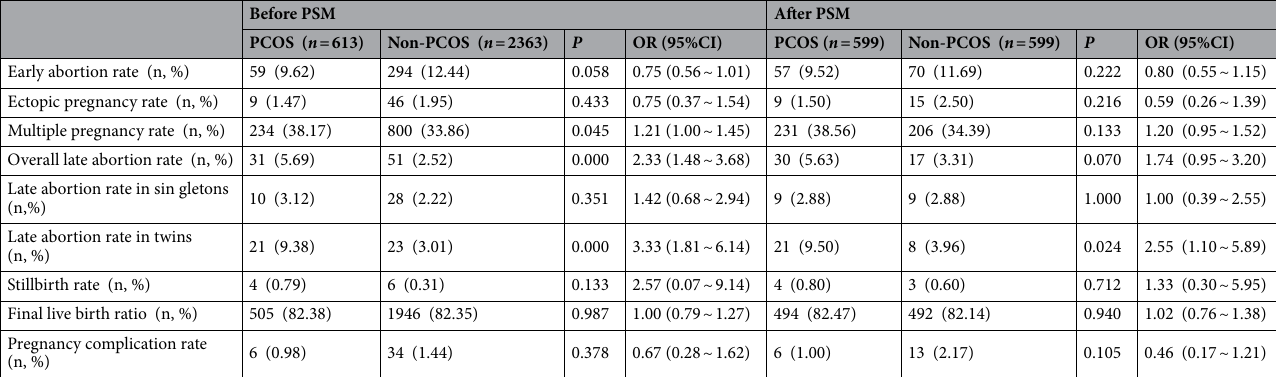
Before PSM After